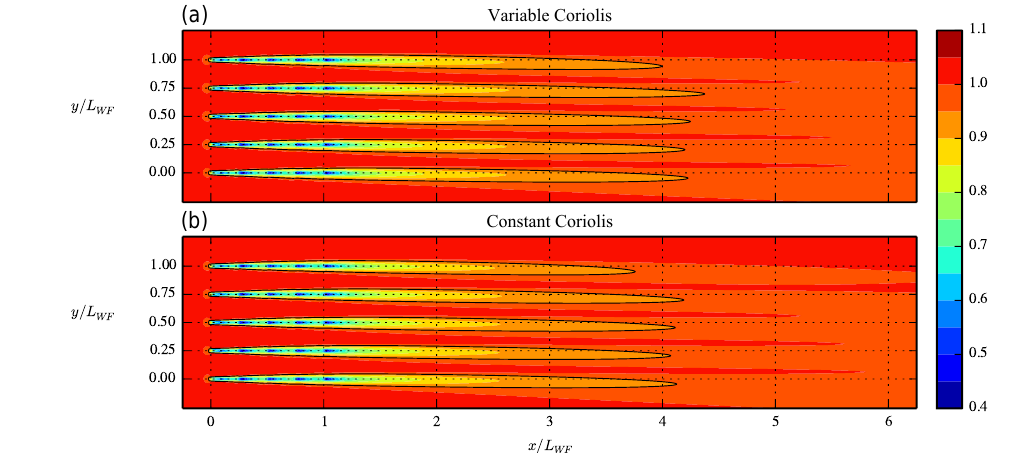
Figure 8. Stream-wise velocity at hub height, normalized by the free stream. Wind farm represented by 25ADs. Contour line represents 95% recovered velocity.